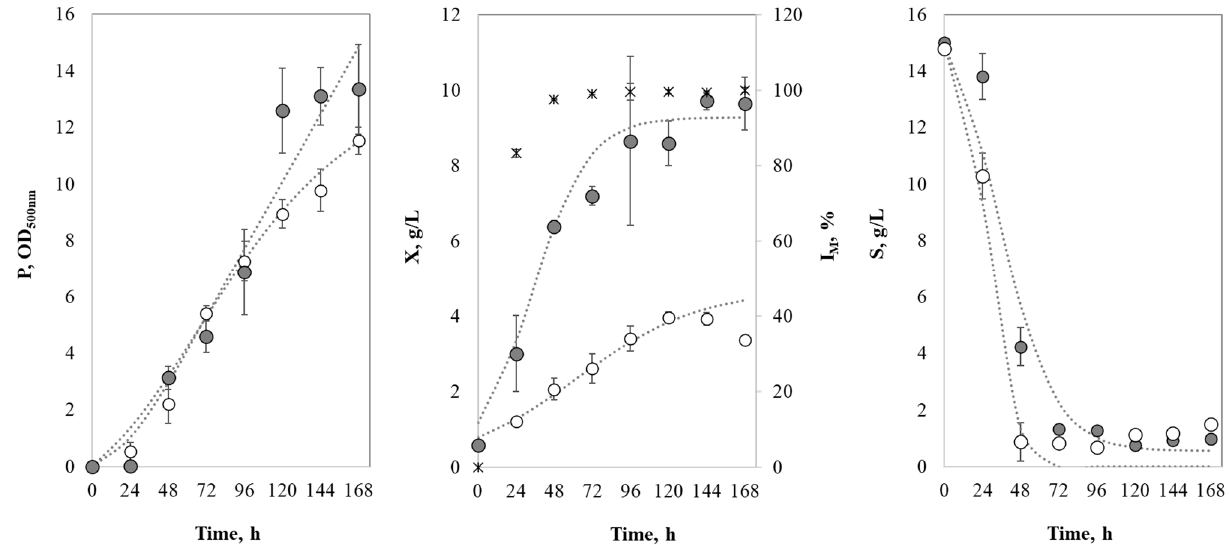
Figure 5. Kinetics of free (white circles) and immobilized cells (gray circles) of Talaromyces atroroseus GH2 in a single batch. Asterisks represent the immobilization percentage and dashed lines are the growth kinetic model’s lines. Pigments, (P), biomass (X), immobilization capacity (I M ) and substrate (S). Error bars depict the standard deviation between three replicates. Table 4. Growth, production and substrate consumption model parameters and goodness of fit. Parameter Control